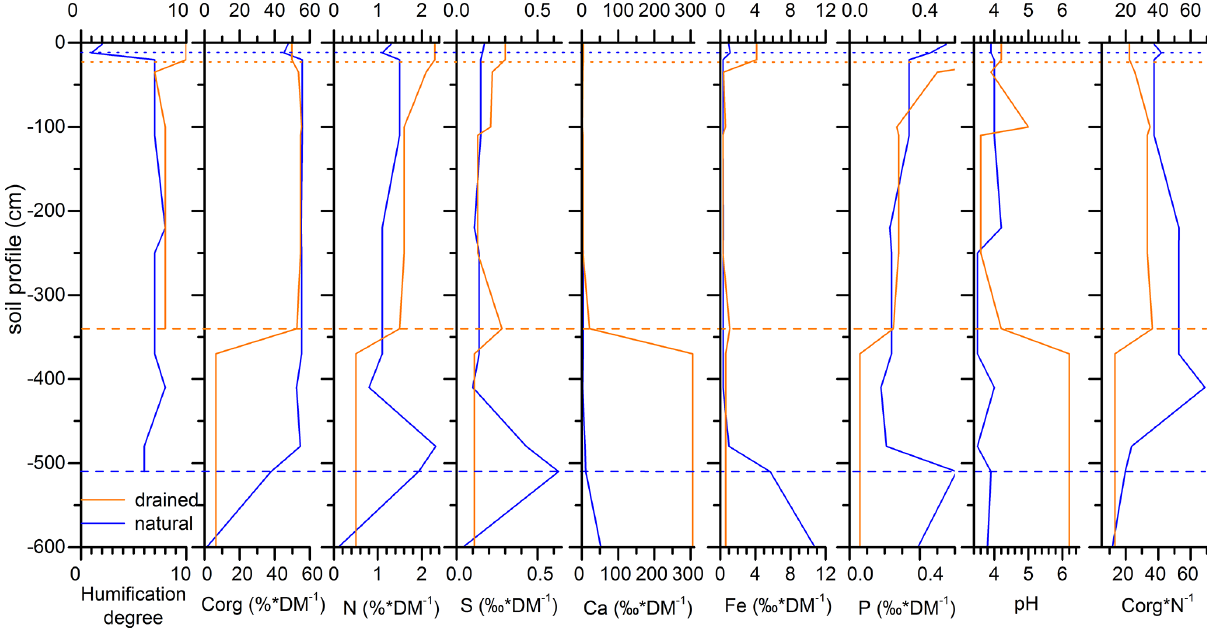
Figure 2. Soil characteristics and element concentrations of the different peat layers at the natural and the drained sites (Corg: organic carbon, N: nitrogen, S: sulfur, Ca: calcium, Fe: iron, P: phosphorus, DM: dry matter). Dotted lines indicate threshold between frequently water-saturated layer and permanent water-saturated layer. Dashed lines indicate threshold between peat and mineral soil layer. Data are provided by the analysis of one soil profile at each